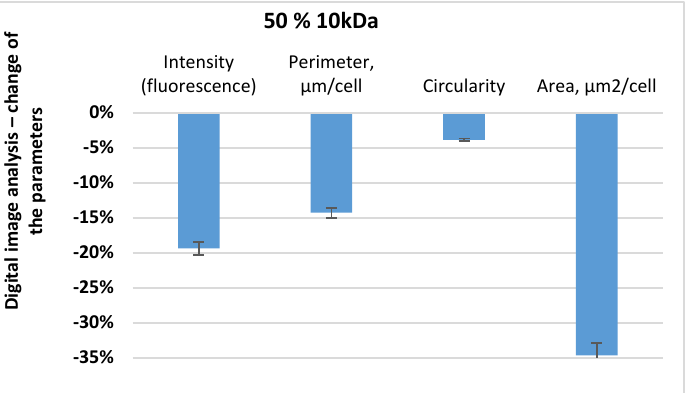
Figure 8. Fluorescence images of E. coli after 1 h incubation with peptide fraction with MW below 10 kDa.